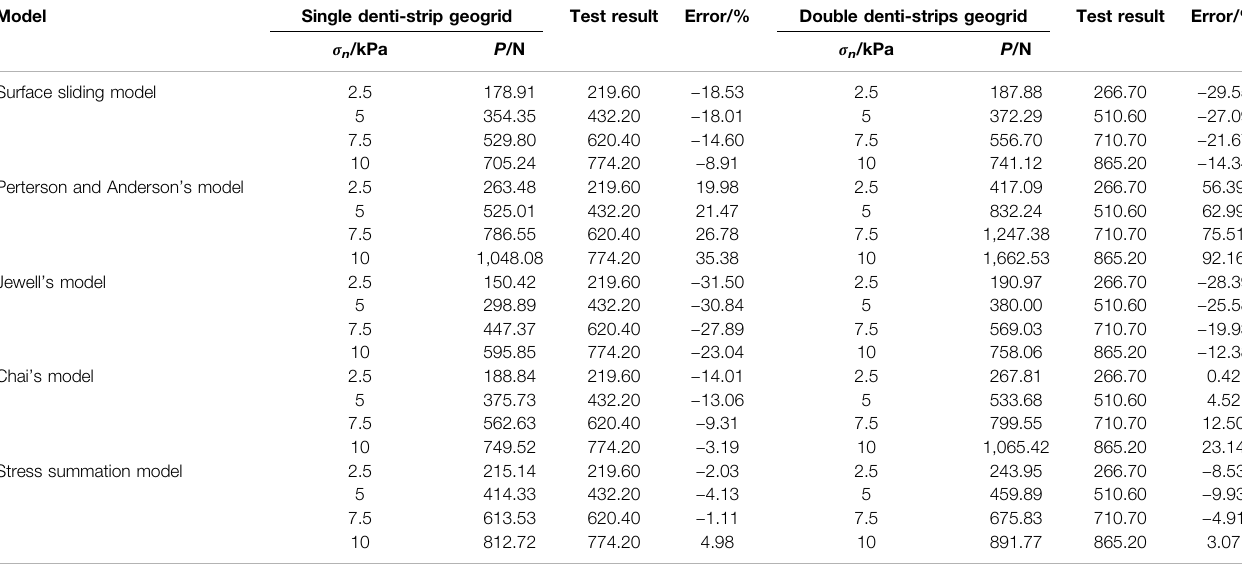
TABLE 4 | Results of models for single and double denti-strip(s) reinforcement. Model